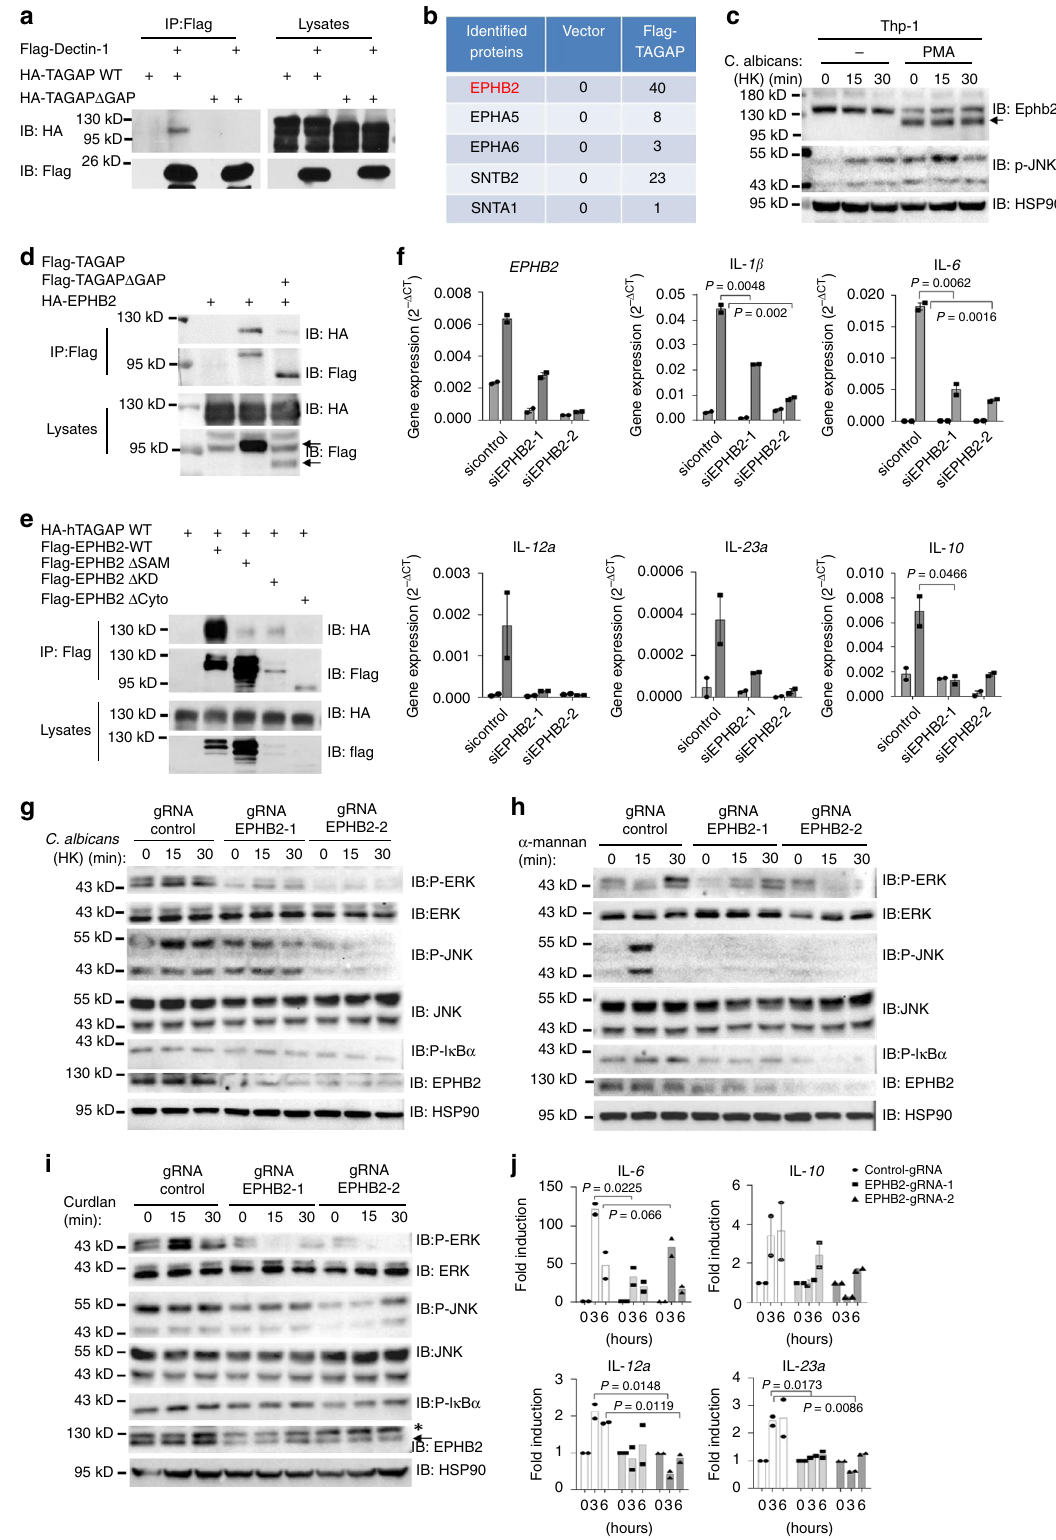
residues Y310, Y596, and Y730 of TAGAP could be phosphory- lated by a tyrosine kinase, so we explored whether EPHB2 phosphorylates TAGAP at these three sites. Interestingly, EPHB2 can strongly phosphorylate wild-type TAGAP, whereas the mutation of TAGAP Y310 largely abolished its